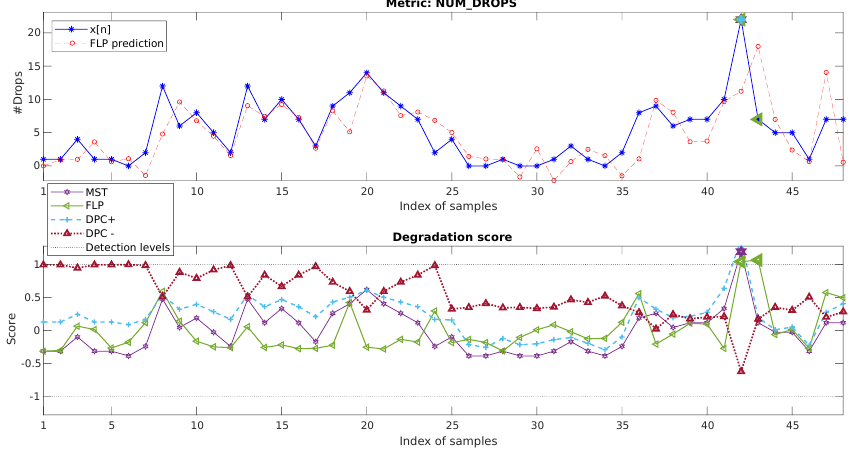
Figure 13. Two-day data of the hourly metric NUM_DROPS, its prediction using the baseline linear filter ( top ), and its absolute prediction error ( bottom